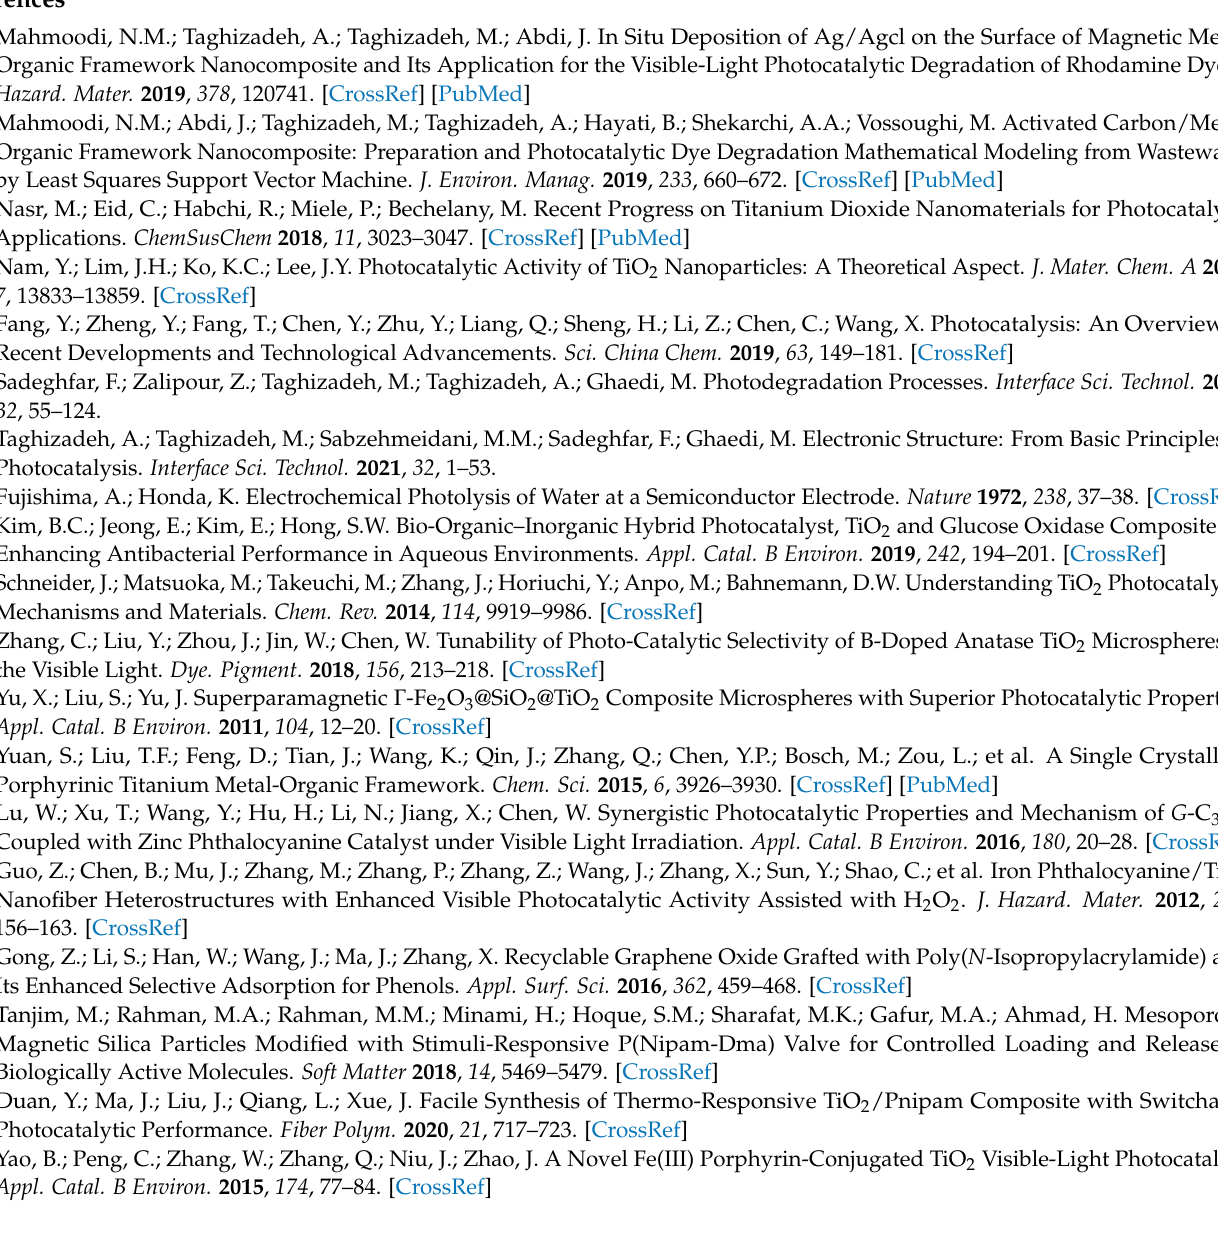
Figure S6. The removal of TC • HCl with ZnPc-g-TiO 2 -g-PNIPAM/H 2 O 2 under visible light. Figure S7. Kinetics curves of RhB and MB. Scheme S1. The procedure of ZnPc